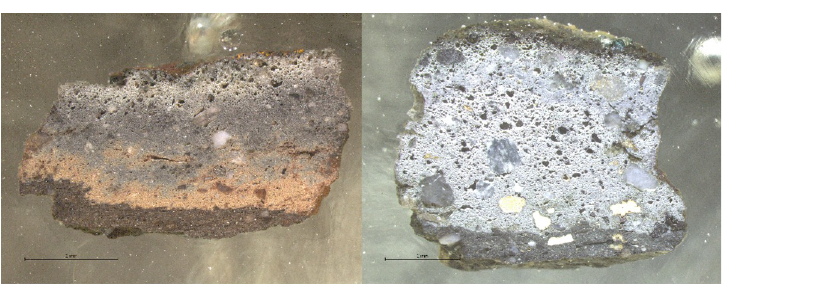
Fig 3. Samples E13 (left) and F12 (right). Note the different ceramic paste colours.